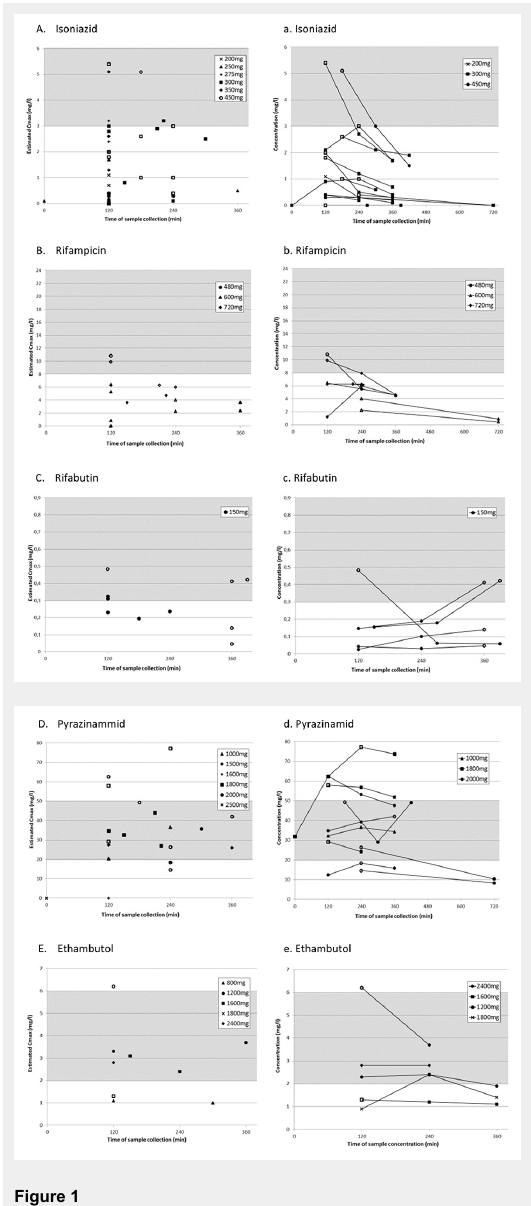
Panels A-E represent the highest measured concentration (estimated C max ) from each sampling period for each antituberculosis drug with its corresponding dosages. Panels a-e represent sampling periods with multiple consecutive measurements. For all panels: Grey area shows published reference ranges [13]. White symbols represent antituberculosis drug levels determined during multiple sampling periods, black symbols represent levels determined in periods with only one sample